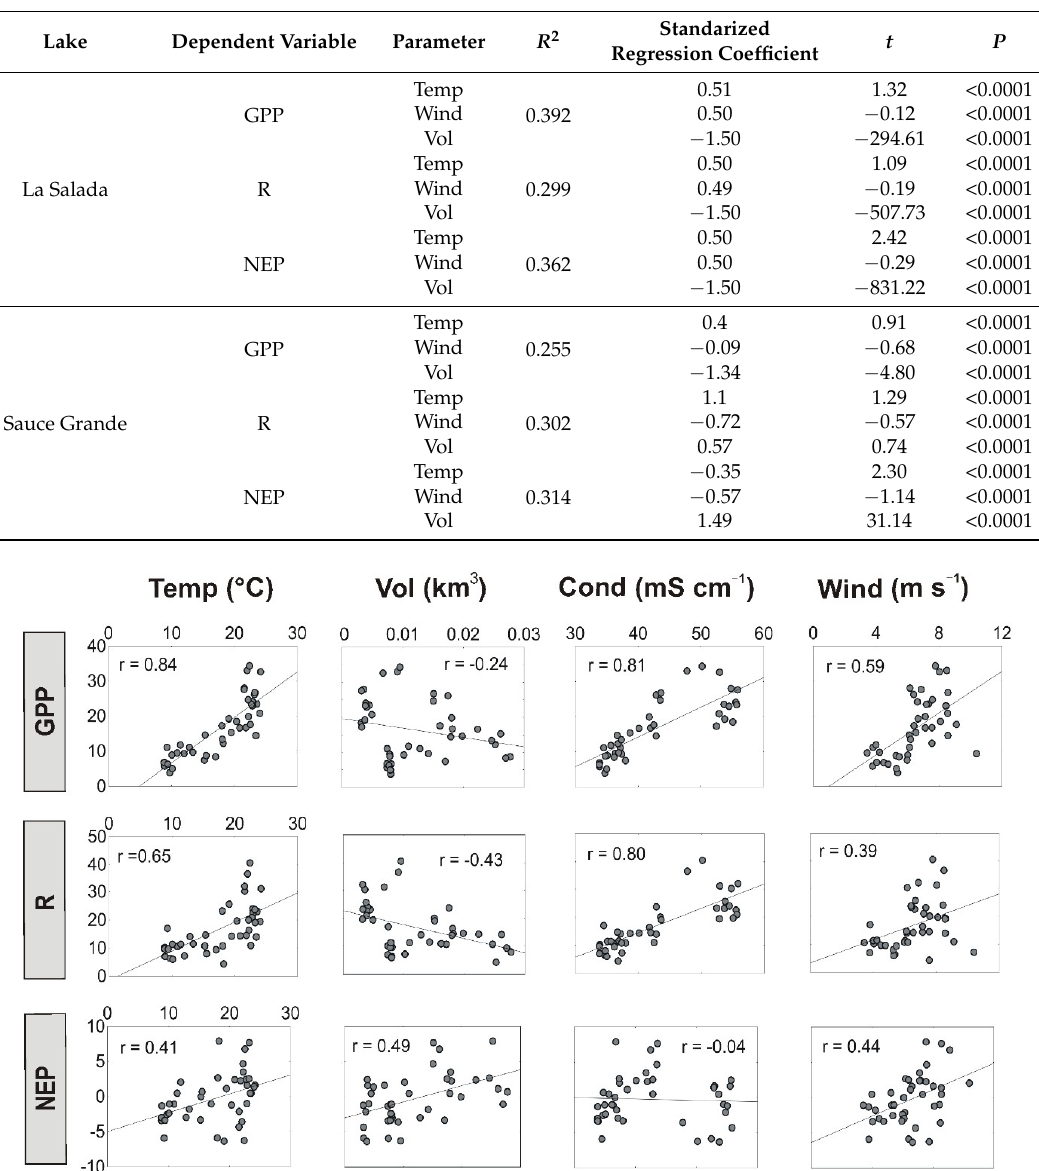
Figure 5. Correlation matrix relating the weekly averages for metabolic variables GPP: Gross primary production, R: community respiration, and NEP: net ecosystem production (mmol m − 3 day − 1 ) with the environmental variables Temp: water temperature ( ◦ C), Vol: lake volume (m 3 seg − 1 ), Cond: electrical conductivity (mS cm − 1 ), and Wind: wind speed (m s − 1 ) for the La Salada lake during the study period.